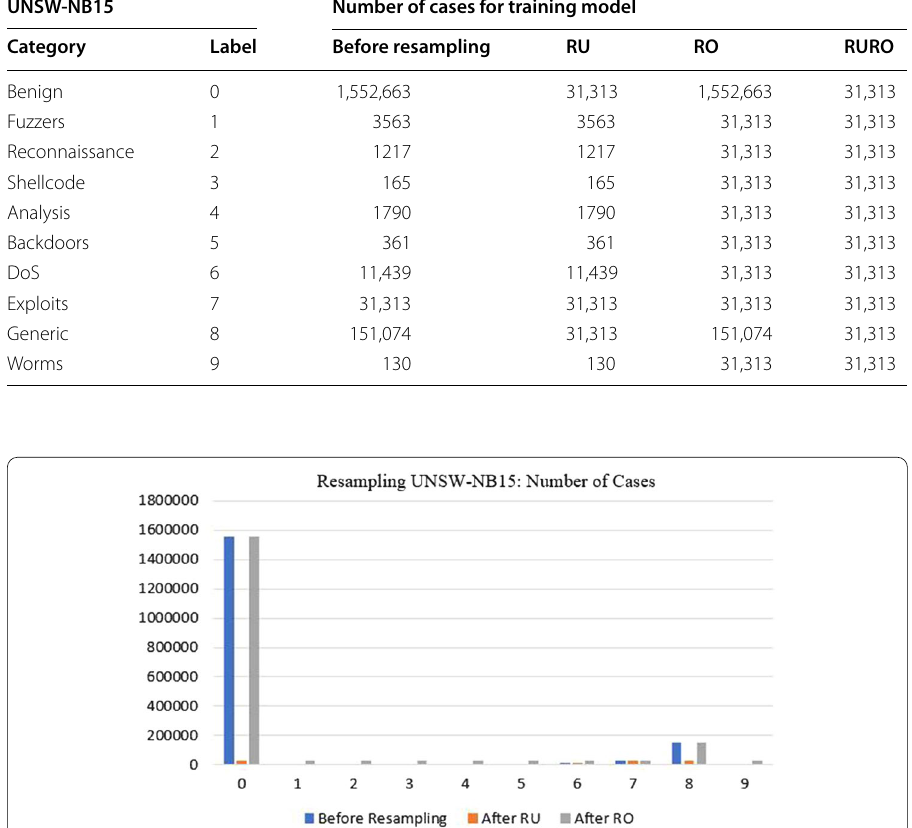
Table 19 Resampling of UNSW-NB15 UNSW‑NB15 Number of cases for training model